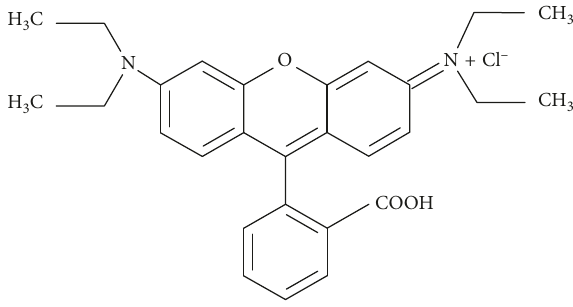
Figure 1: Molecular structure of Rh-B